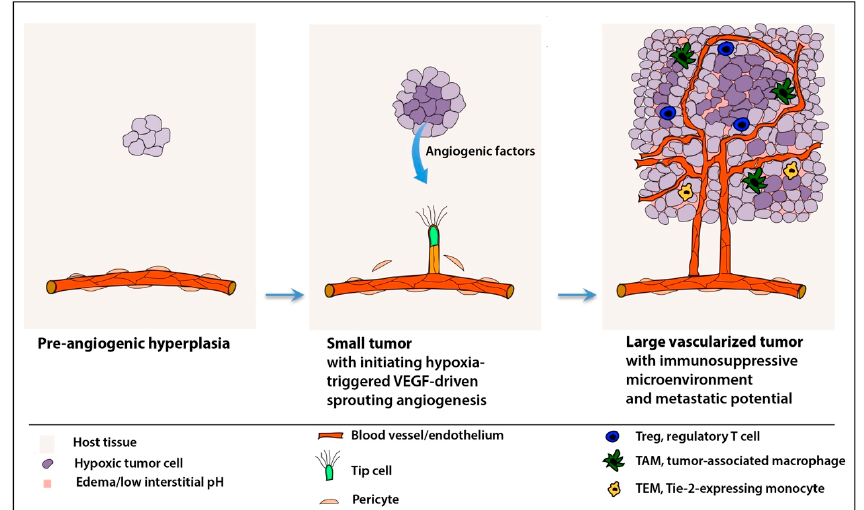
Figure 1. Steps of tissue hypoxia-triggered neoangiogenesis and progression of neoplastic lesions. VEGF: vascular endothelial growth factor. The initially avascular tumor cell mass, upon reaching a critical size, cannot ensure its further growth without the trophic support of its own circulation. Hypoxic cells of the tumor mass, via angiogenic factors, initiate the “angiogenic switch” by stimulating nearby endothelial cells of the microvasculature of the host / parental tissue in which they arise. Tumor angiogenesis initiates with a detachment of perivascular cells, the degradation of vessel basal lamina and angiogenic sprouting by the formation of filopodia bearing leading-edge endothelial tip cells from the parental vessels. Newly formed sprouts build anastomoses followed by lumen formation and the recruitment of the pericytic cells necessary for perivascular investment. Angiogenesis will continue as the expansive growth of the tumor mass requires further supply. This process forms a vicious circle that is fueled by the tumor vessel leakiness and the suboptimal tumor perfusion that cannot e ffi ciently relief tissue hypoxia. Recruited inflammatory cells contribute significantly to a hostile microenvironment that boosts further uncontrolled neoangiogenesis and play a role in the evasive resistance of solid tumors. Abbreviations: Treg, regulatory T cell; TAM, tumor-associated macrophage; TEM, Tie-2- expressing